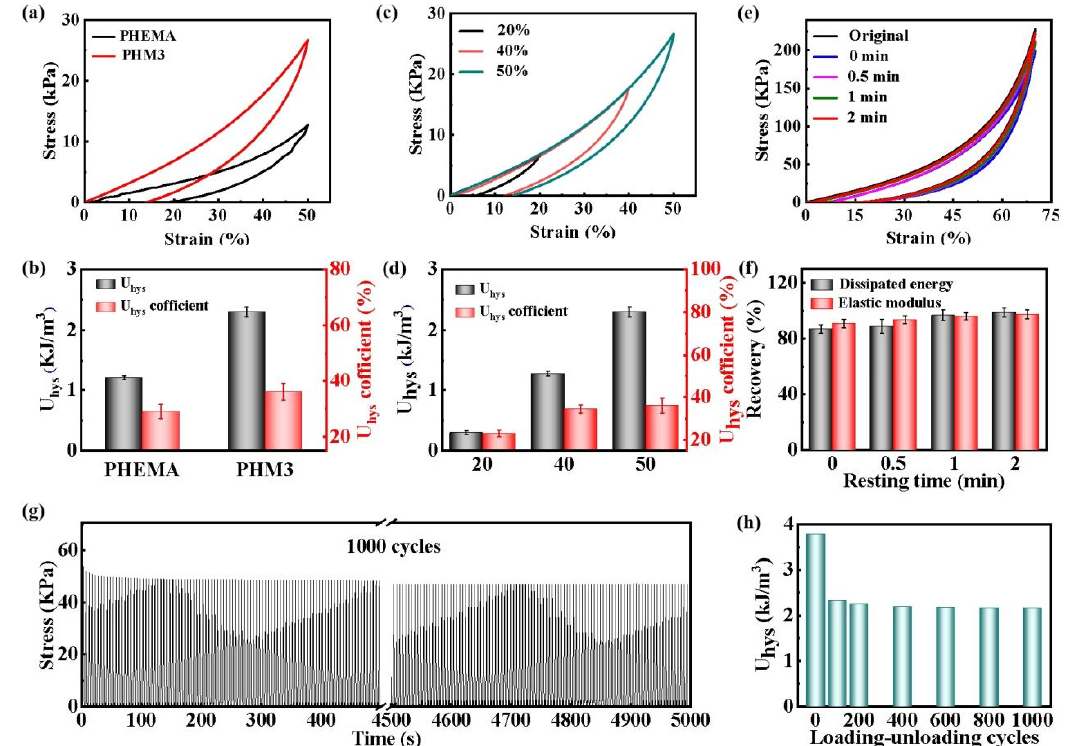
Figure 4. Energy dissipating capability, self-recovery property, and fatigue resistance of the PHMx hydrogels. ( a ) Compressive loading-unloading curves and ( b ) the dissipation energy U hys and coefficient of U hys of the PHEMA and PHM3 hydrogels at a maximum strain of 50%. ( c ) Compressive loading and unloading curves and ( d ) the dissipation energy U hys and coefficient of U hys of the PHM3 hydrogels at different maximum strains. ( e ) Cyclic tensile loading-unloading curves and ( f ) the recovery rate of the dissipation energy and elastic modulus for PHM3 hydrogels at different waiting times. ( g ) The variation of the maximum stress corresponds to 1000 times the continuous compression at the maximum strain of 50% and (h) the corresponding dissipation energy U hys .